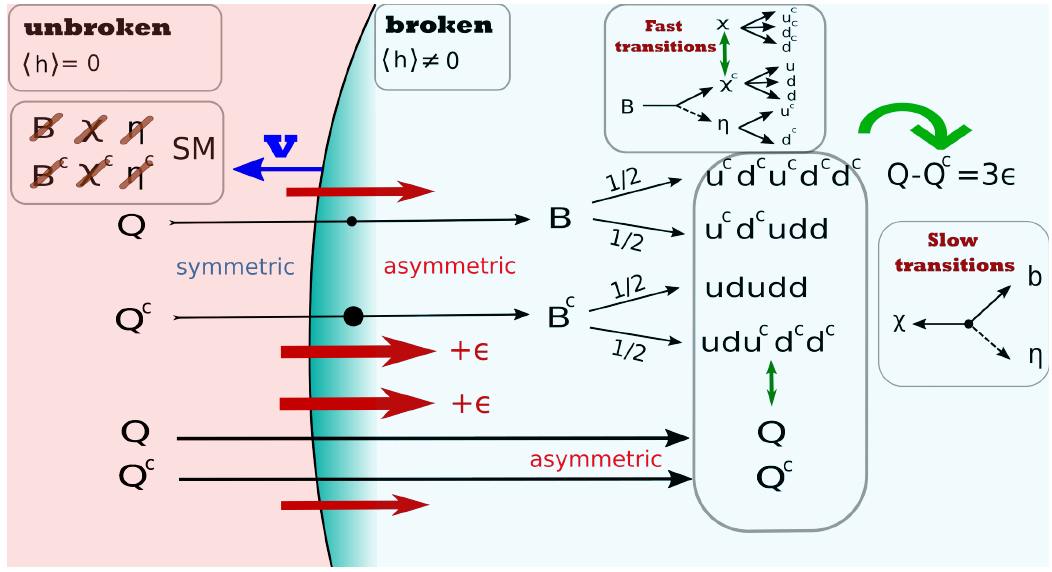
Figure 3 . Mechanism at play in the low energy